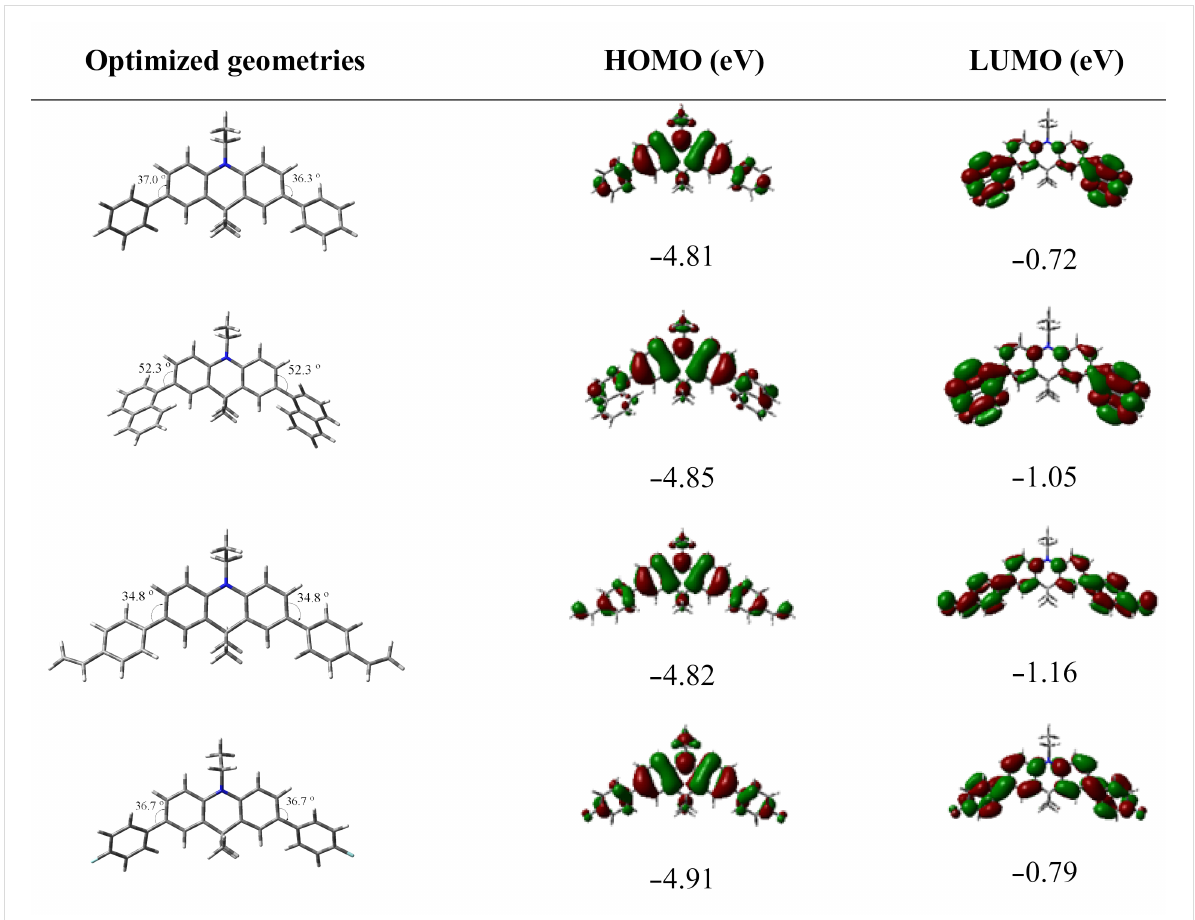
Figure 1: Theoretically calculated HOMO and LUMO levels distributions and optimized geometries of 3–6 DFT calculations were performed at the B3LYP/6-31G(d,p) level [29].